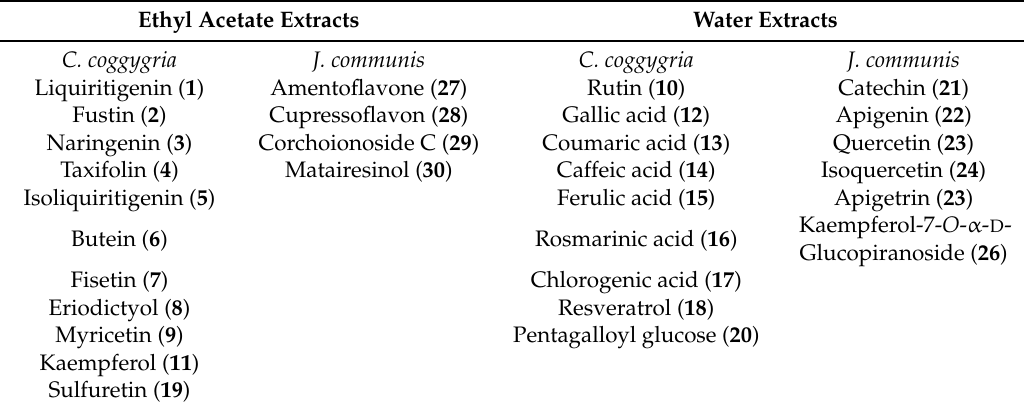
Table 1. Major components from C. coggygria and J. communis extracts. Ethyl Acetate Extracts Water